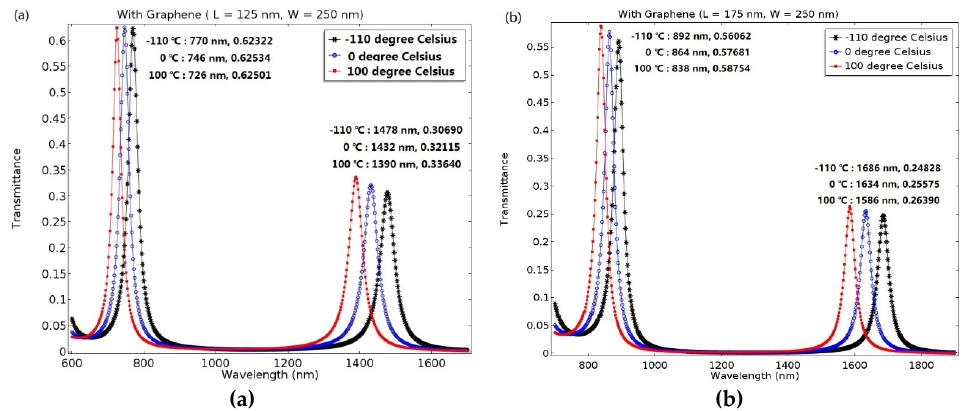
Figure 4. Transmittance of the plasmonic resonator with different structural parameters versus wavelength for –110 °C, 0 °C, and 100 °C, respectively. ( a ) At L = 125 nm, the maximum values for mode 1 and mode 2 are 0.63 and 0.34, respectively. ( b ) At L = 175 nm, the maximum values for mode 1 and mode 2 are 0.58 and 0.26, respectively.